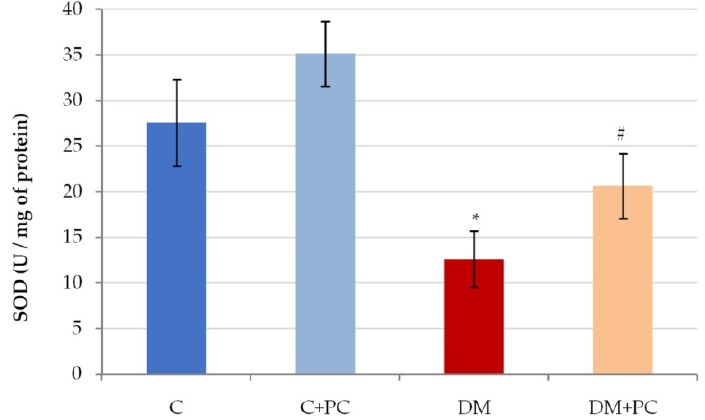
Figure 11. The activity of superoxide dismutase in plasma of control rats, rats with experimental diabetes mellitus, with and without PC concentrate. C–normal untreated control animals; C + PC–animals that were per os administrated PC concentrate (daily dose of 45 mg/kg bw of polyphenolic complex for 14 days); DM–rats with experimental diabetes mellitus; DM + PC–animals with experimental diabetes mellitus that were per os administrated PC concentrate (daily dose of 45 mg/kg bw of polyphenolic complex for 14 days). *-significant difference compared to control ( p < 0.05); #-significant difference compared to diabetes mellitus ( p < 0.05).